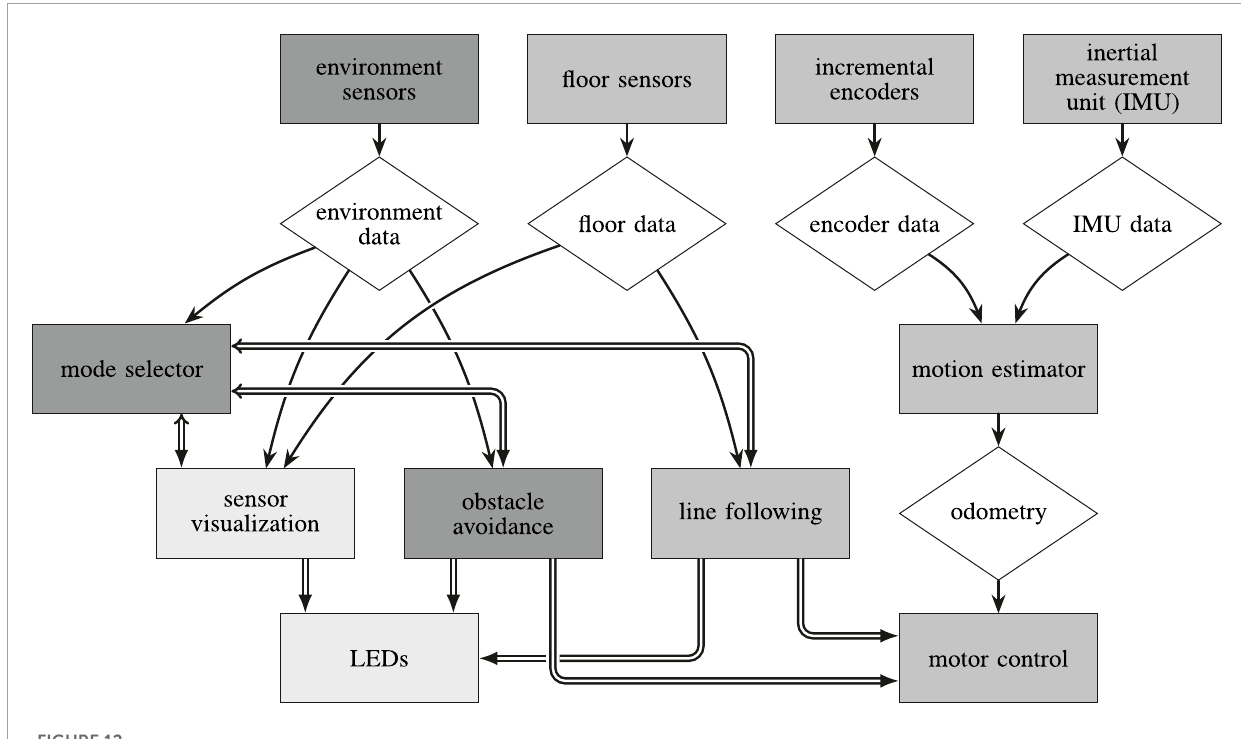
FIGURE 12 Example architecture as implemented on the AMiRo platform. Rectangles depict nodes, whereas topics are visualized as diamond shapes. Publish–subscribe interaction is indicated by . and represent complete and “fire-and-forget” RPC interaction, respectively. Various shadings of nodes indicate that those are executed on different MCUs. Communication is hence tunneled over CAN by bridge nodes as required (not